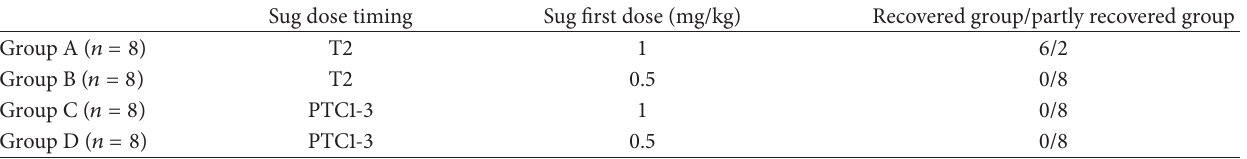
Table 2: Breakdown of recovered group and partly recovered group.